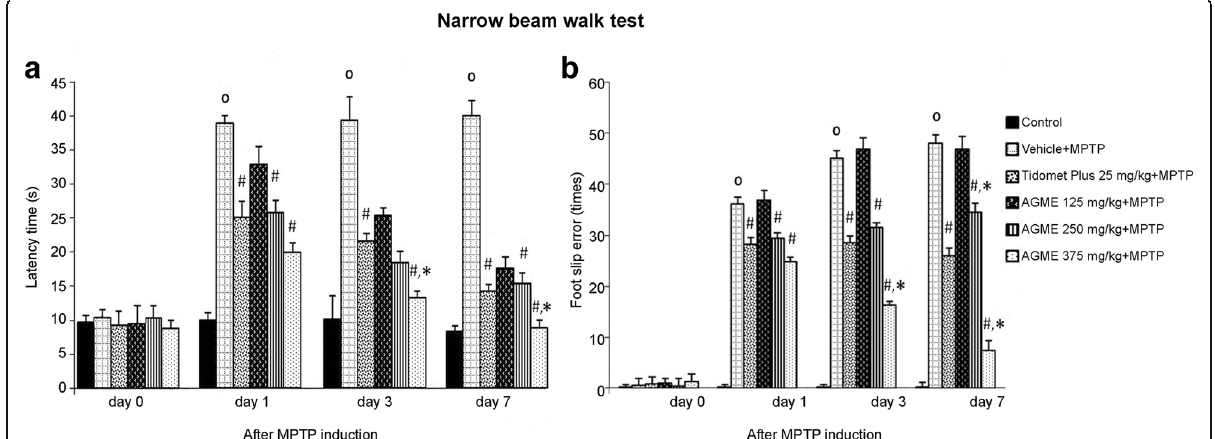
Fig. 3 Effect of AGME on latency time ( a ) and foot slip errors ( b ) on the narrow beam test at 0, 1, 3, and 7 days after MPTP induction. Each data column represents the mean ± SD ( n = 8/group, o - p < 0.01 compared with the control group; #- p < 0.05 compared with the vehicle-treated group; *- p < 0.05 compared with the Tidomet Plus-treated group)